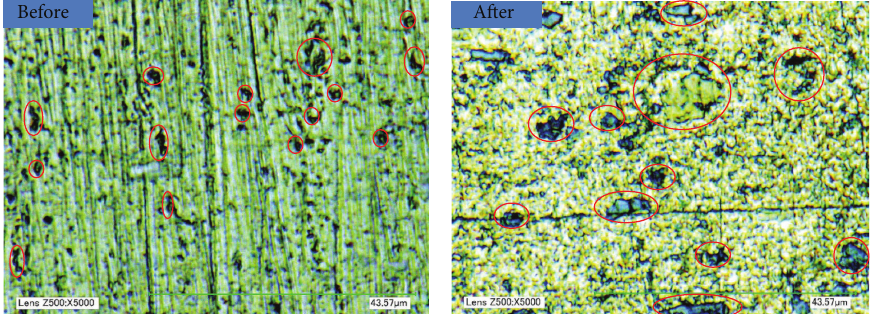
Figure 4: Optical microscopy images of 3003-T3 aluminum before and after (112-hour) test with (reference fluid, without nanoparticles)